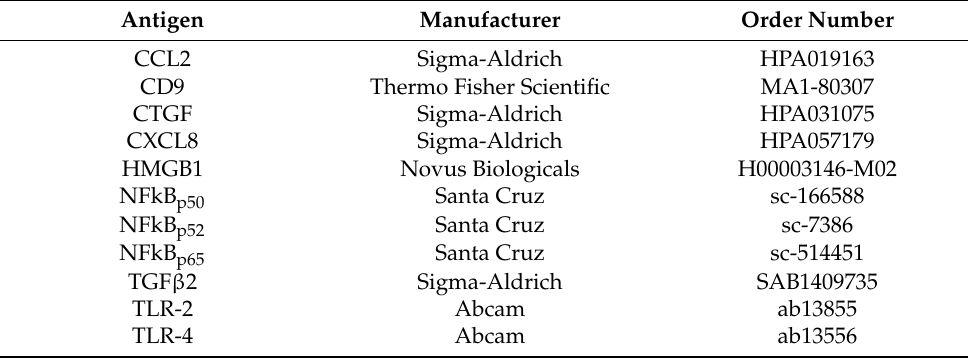
Figure A2. Setup of the photopic Ganzfeld ERG. ( A ) For photopic Ganzfeld ERG, a green back- ground light is permanently present during the measurement, and the animal under investigation is positioned horizontally on a custom-made platform. ( B ) Two reference electrodes are placed on the animal, one on the head centered between the ears, and one on the tail, near the root of the tail. ( C ) The measuring electrodes (gold ring electrodes) are applied to the cornea with light pressure. Methocel was applied between the electrode and the cornea. Table A1. Antibodies used for antibody-based microarray.